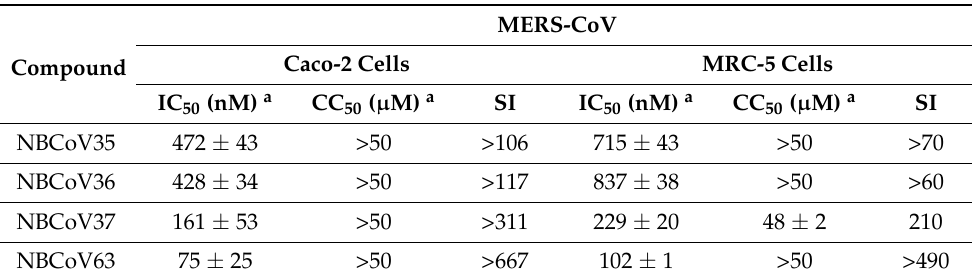
Table 4. Antiviral activity of the NBCoV small molecules in the single-cycle assay in two cell lines against pseudovirus NL4-3 ∆ Env -NanoLuc/MERS-CoV (IC 50 ), toxicity (CC 50 ), and